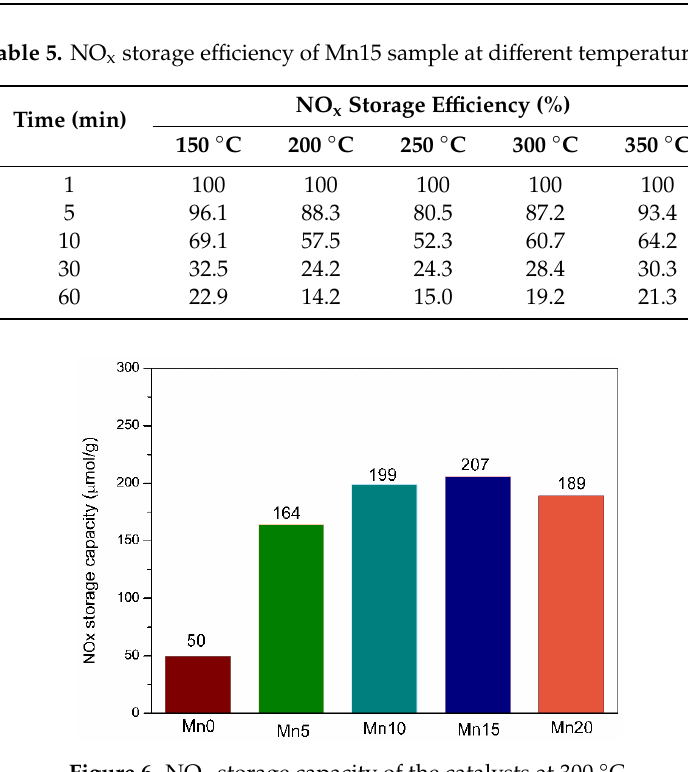
Figure 6. NO x storage capacity of the catalysts at 300 °C.